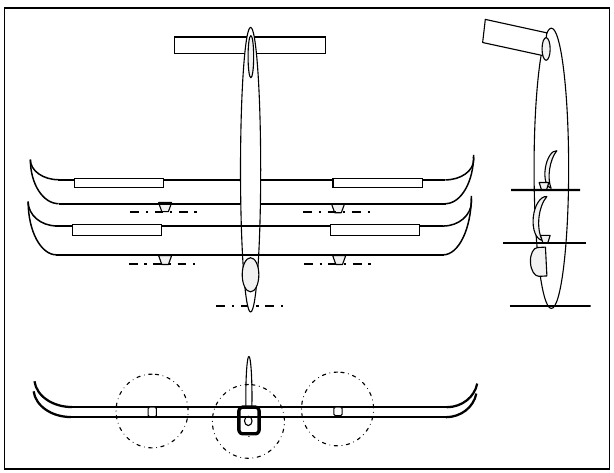
Figure 4. Drawings of the Solar Airplane prototype